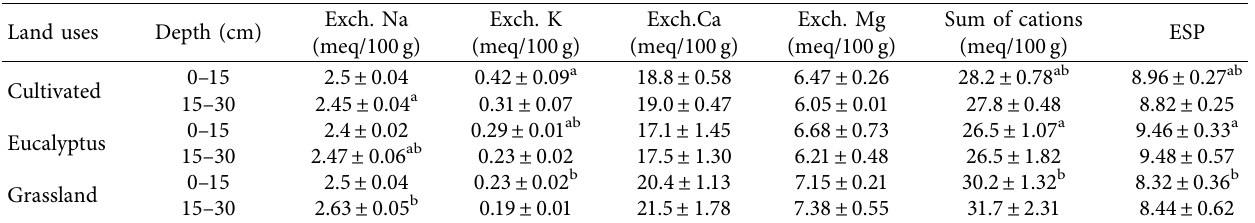
Table 4: Mean ( ± SEM) of selected soil exchangeable cations, sum of cations, and ESP across land uses and soil depths. Land uses